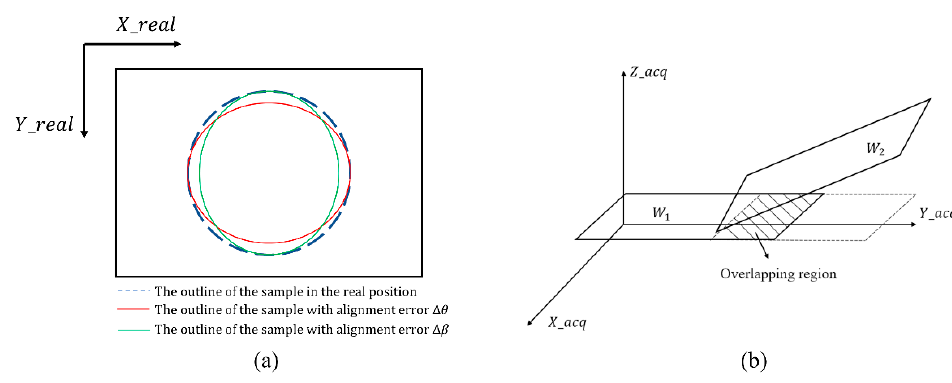
Figure 6. ( a ) the profile of sample with alignment errors and without alignment errors. ( b ) illustration of the discrete data stitching algorithm based on overlapped region between the tilted planes.